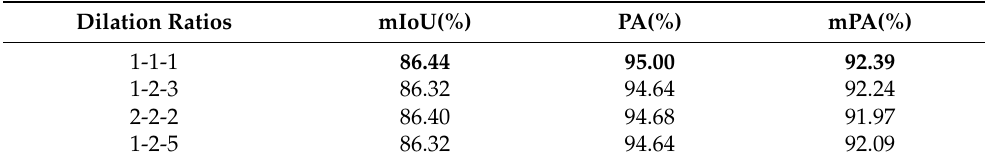
Table 5. Influence of using different ratio combinations for the three 3 × 3 convolutions of the Conv-5 block from ResNet-50 on algorithm performance (bold represents the best result). Dilation